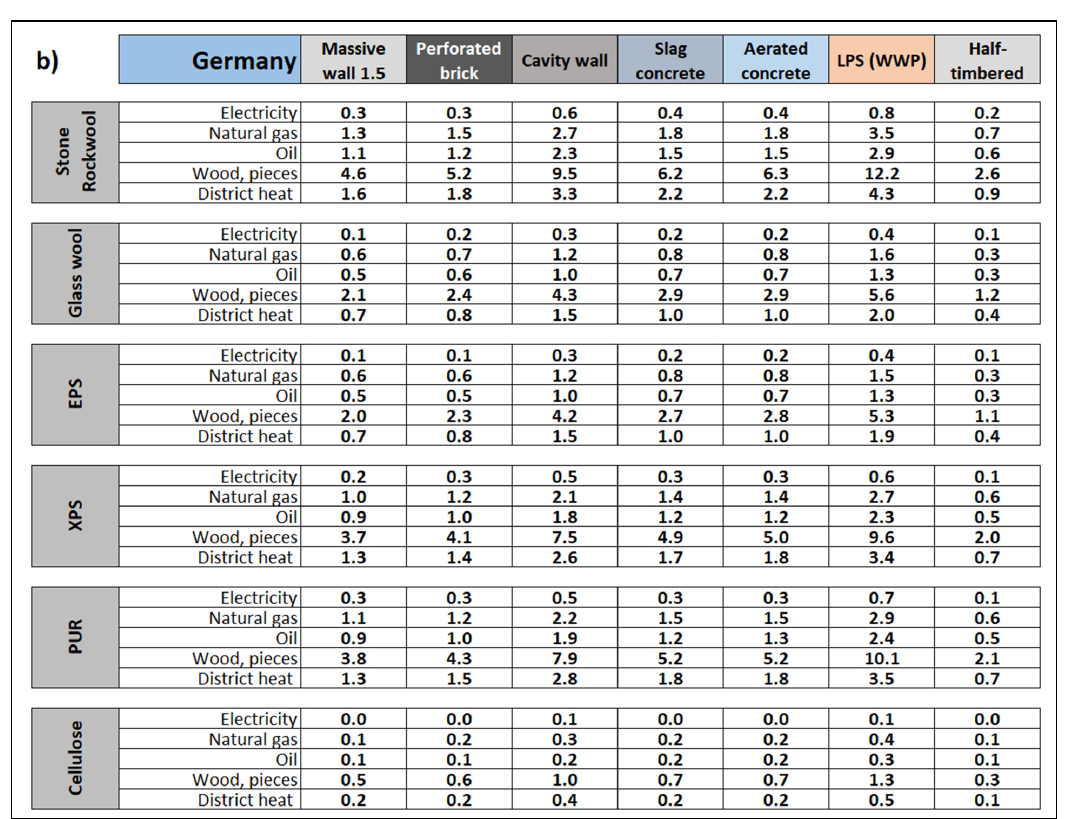
Figure 6. ( a ) CPP values chart for Germany. ( b ) CPP values for Germany. After averaging the data available from the EPDs available for Germany, the PEFn values for Germany, emission factors and climatic conditions for Berlin, the highest CPP values are for existing walls with the highest resistance, for spaces heated with biomass insulation and for Stone/Rockwool insulation (up to 12.2 years), PUR (up to 10.1 years) and XPS (up to 9.6 years). The lowest CPP values are for the existing walls with the least resistance, for spaces heated with electricity and for cellulose (less than 0.1 year), glass wool (0.1 year) and EPS (0.1 year). Depending on the energy source, the average CPP ranges from 0.3 for electricity to 4.0 for biomass, and depending on the type of insulation, it ranges from 0.3 for cellulose to 2.6 for stone/rockwool, as shown in Table 9a (CPP for various energy sources, regardless of the insulation method) and Table 9b (CPP for different insulation materials, regardless of heating method). Table 9. ( a ) Average CPP values for different energy sources. ( b ) Average CPP values for various insulation materials.